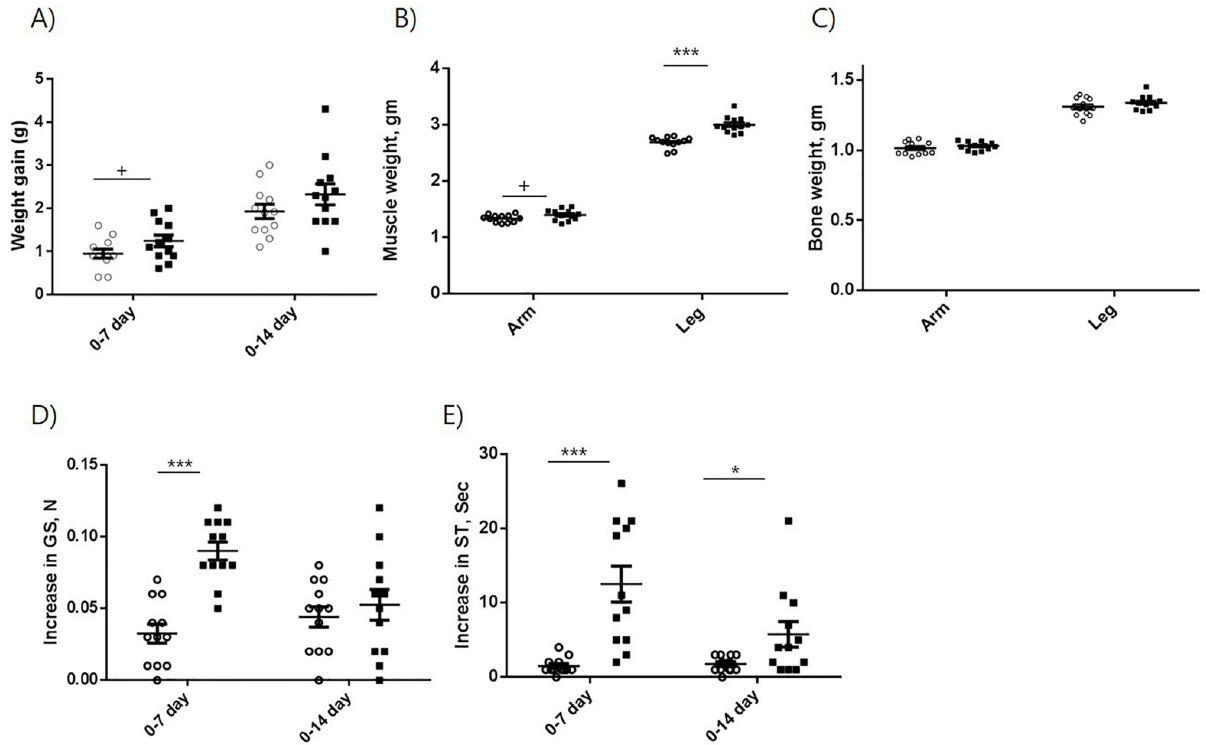
Fig 3. Effects of MBP-Pro45-70-His6 on body wt gain (A), grip strength (B), swimming time (C), muscle wt (D), and bone mass (E). Open circle ( � ) and closed square ( ■ ) indicate 0 and 20 mg/kg body wt administration of MBP-Pro45-70-His6, respectively. Student‘s t -test was used to compare the mean difference. +, P < 0.1; � , P < 0.05; �� , P < 0.01; ��� . P < 0.001.